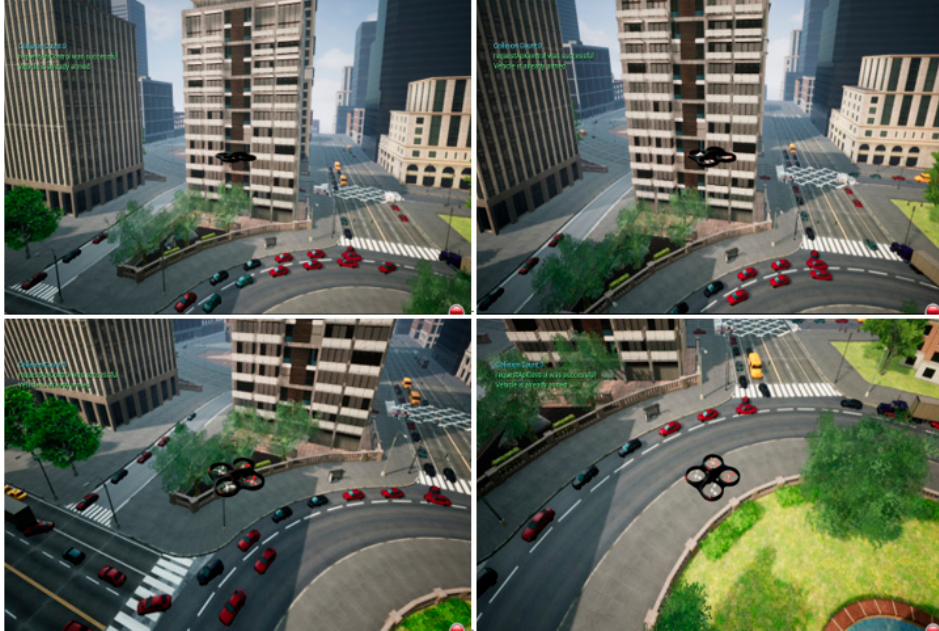
Figure 1. Microsoft AirSim v1.2 is a realistic virtual CityEnviron environment scenario with an AirSim drone simulator from various angles on a city map.